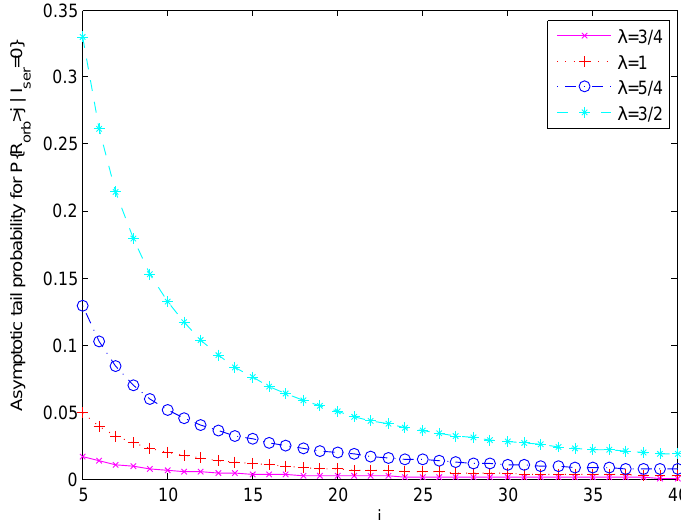
Figure 1. Impact of the arrival rate λ on the asymptotic tail P { R orb > j | I ser = 0 } .